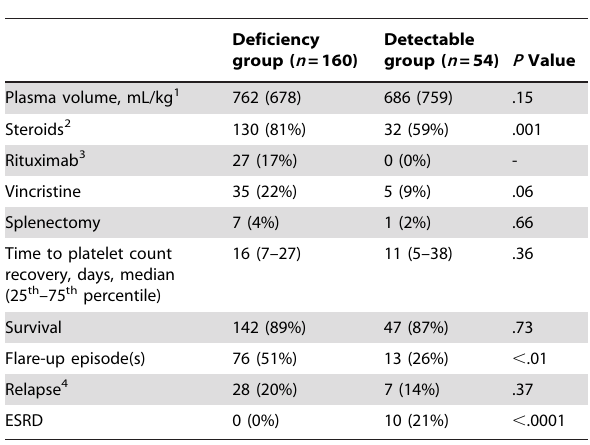
Table 3. Treatment and Outcome in 214 Patients with Thrombotic Microangiopathy According to ADAMTS13 Activity.